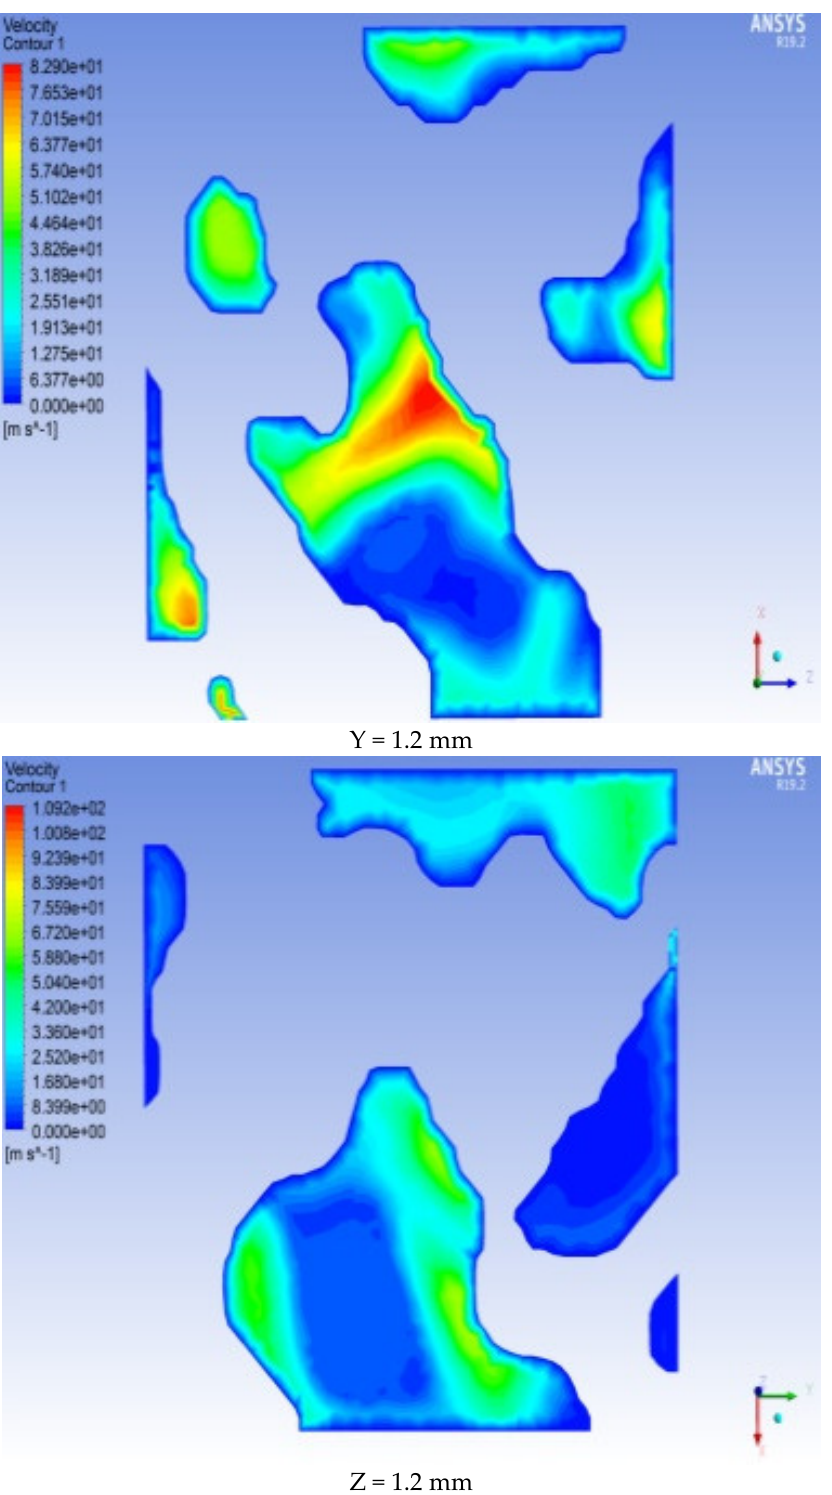
Figure 14. X, Y, and Z positive single channel seepage velocity cloud diagram at different